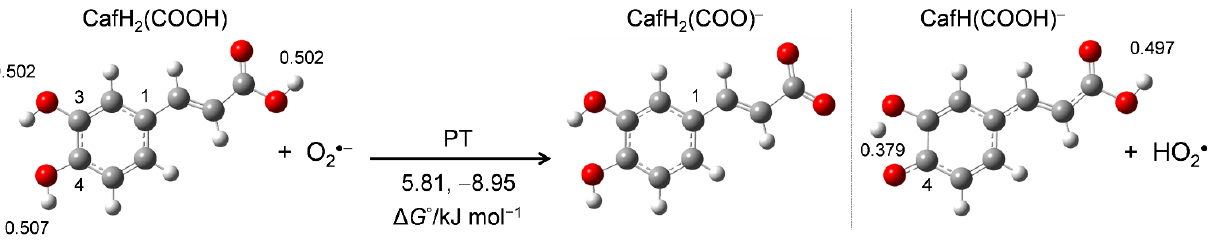
B3LYP/PCM/6-311+G(3df,2p). The ∆ G ◦ s (kJ mol − 1 , 298.15 K) of PT and the NBO-determined